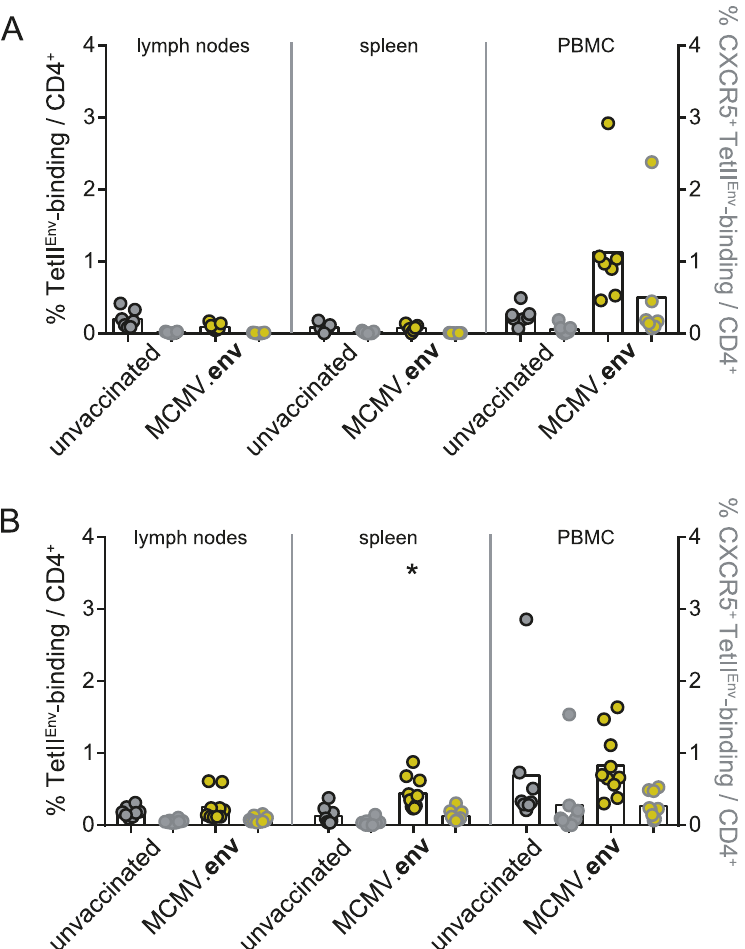
Fig 7. Distribution of F-MuLV-specific CD4 + T cells after FV challenge infection. CB6F1 mice were immunized once with MCMV.env and infected six weeks later with 5 000 SFFU FV. Two weeks after immunization (A), or three weeks after the FV infection (B), spleen, lymph node and peripheral blood mononuclear cells were collected and subjected to MHC II tetramer staining for detection of Env 123-141 -specific CD4 + T cells in combination with staining for the chemokine receptor CXCR5 (grey symbols). Data were obtained in two independent experiments, each dot indicates one mouse, bars indicate mean values. Data were analysed for statistically significant differences by One Way ANOVA on Ranks with Dunn’s post test. � indicates statistically significant differences compared to the respective data from unvaccinated mice ( P < 0.05).